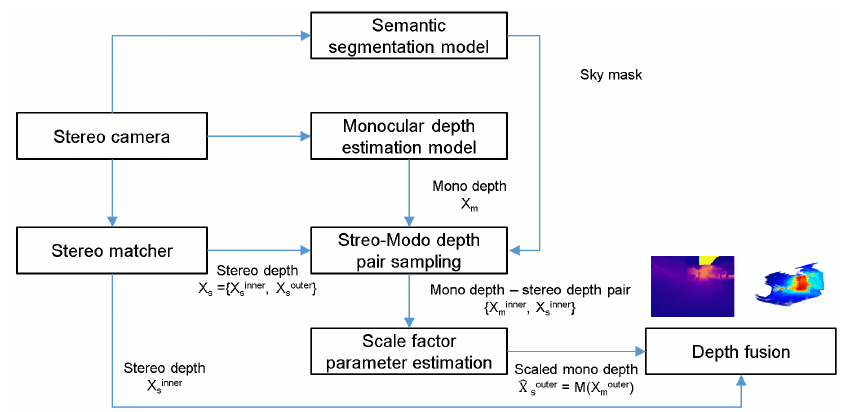
Figure 4. Pipeline of the sensing range extension